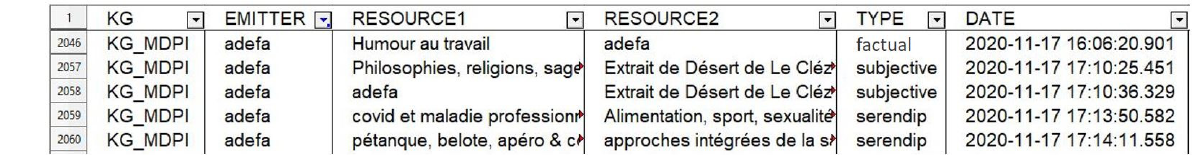
Figure 1. Five viewpoints extracted from the Garden-party experiment.